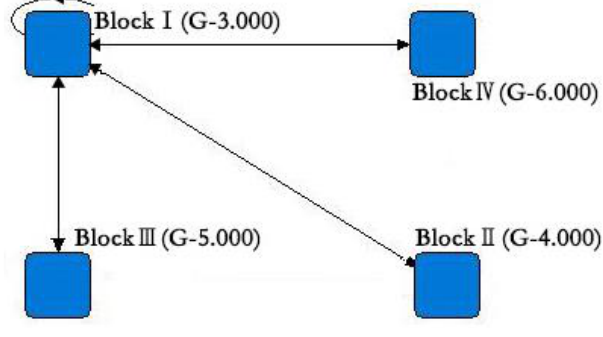
Table 5. Density and image matrixes of spatially related blocks of tourism eco-efficiency.